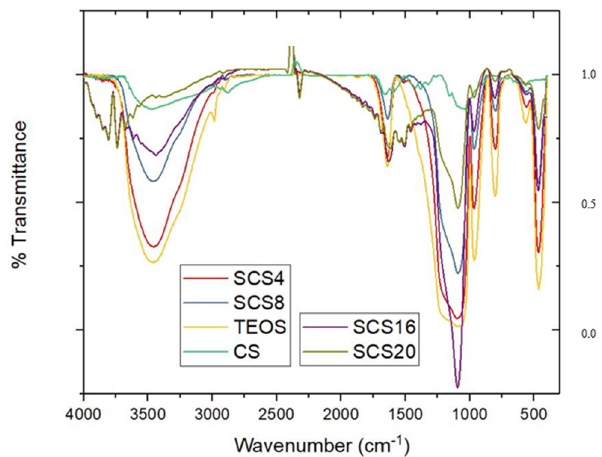
Figure 5. FTIR spectra of the outlined aerogels. CS (green) and TEOS (SiO 2 ) (yellow) are included as a reference. Transmittance is in arbitrary units.